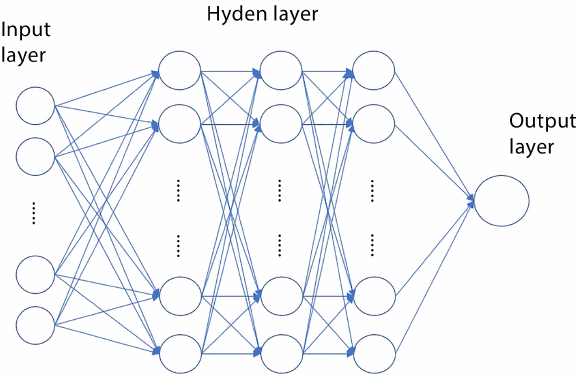
Fig. 1. BP neural